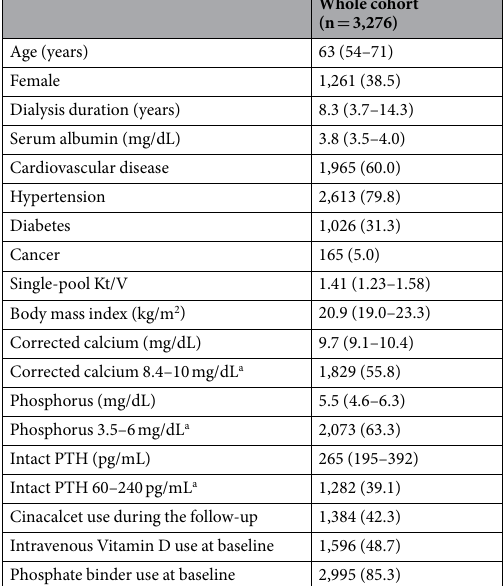
population-level impact of the management of bone-mineral markers in the dialysis population 9 using epidemi- ological measures of population-attributable fractions (PAFs) 10,11 . PAFs indicate the percentage of undesirable outcomes that can be prevented by eliminating the risk factor from the population. In the present context, “suc- cessful” management refers to management that results in prescribed targets being achieved. A previous study using the Fresenius Medical Care North America Patient Statistical Profile system reported that 17.5% of deaths could be prevented by achieving target values of bone-mineral markers (calcium < 10 mg/dL, phosphorus < 5 mg/ dL, and intact PTH < 600 pg/mL) 9 . However, PAFs depend on the prevalence of the risk factor and the strength of the association between the risk factor and the outcome, both of which are greatly affected by population characteristics and by the definition of the risk factor 11,12 . Practice patterns for treating dialysis patients with mineral and bone diseases have changed over time, especially after the introduction of cinacalcet 2,13 . An updated